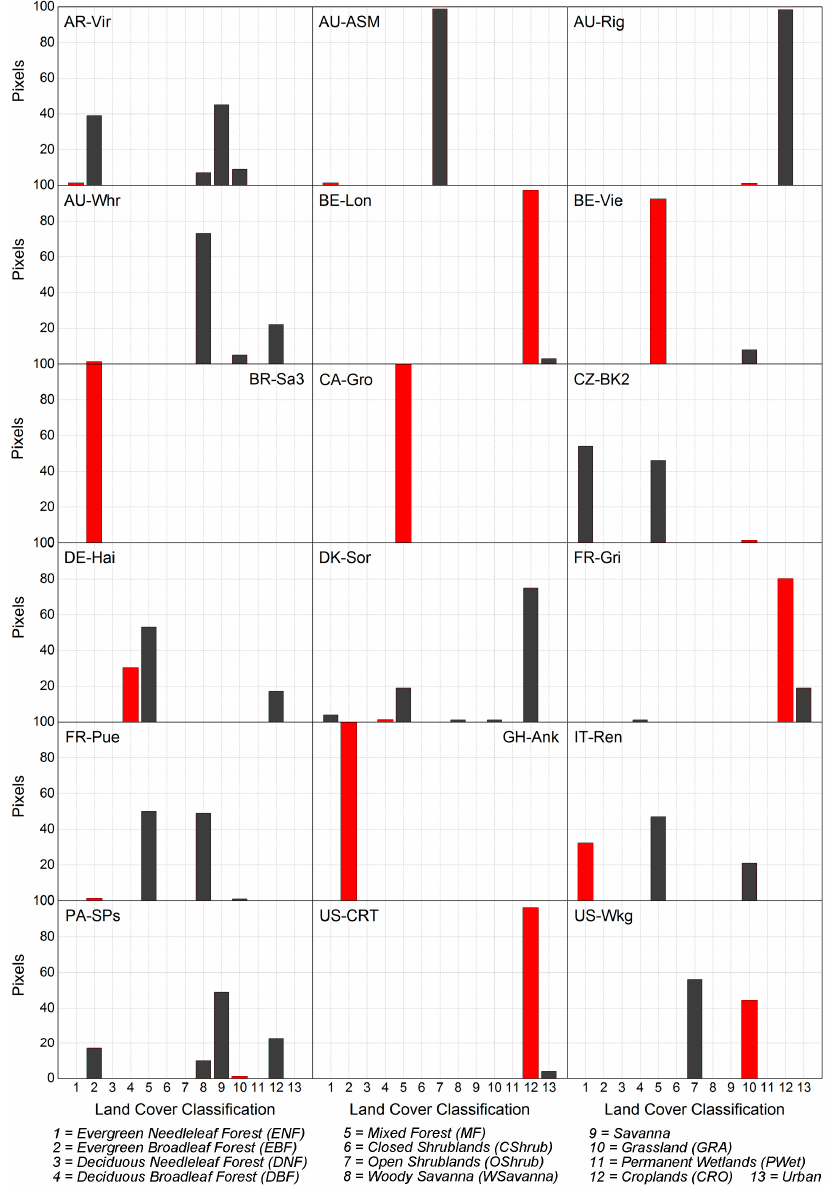
Figure 6. University of Maryland (UMD) land cover classification (MCD12Q1 Collection 5.1, Land Cover Classification Type 2) for the eighteen sites. The red columns indicate the actual land cover at each site.